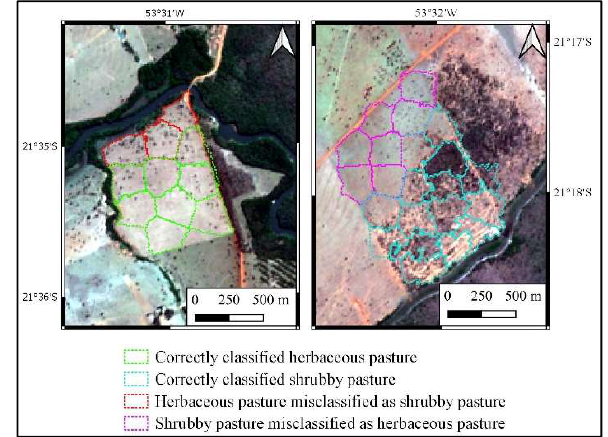
Figure 5. Example of misclassified superpixels of both classes due the landscape heterogeneity in pastures (Sentinel-2 true colour